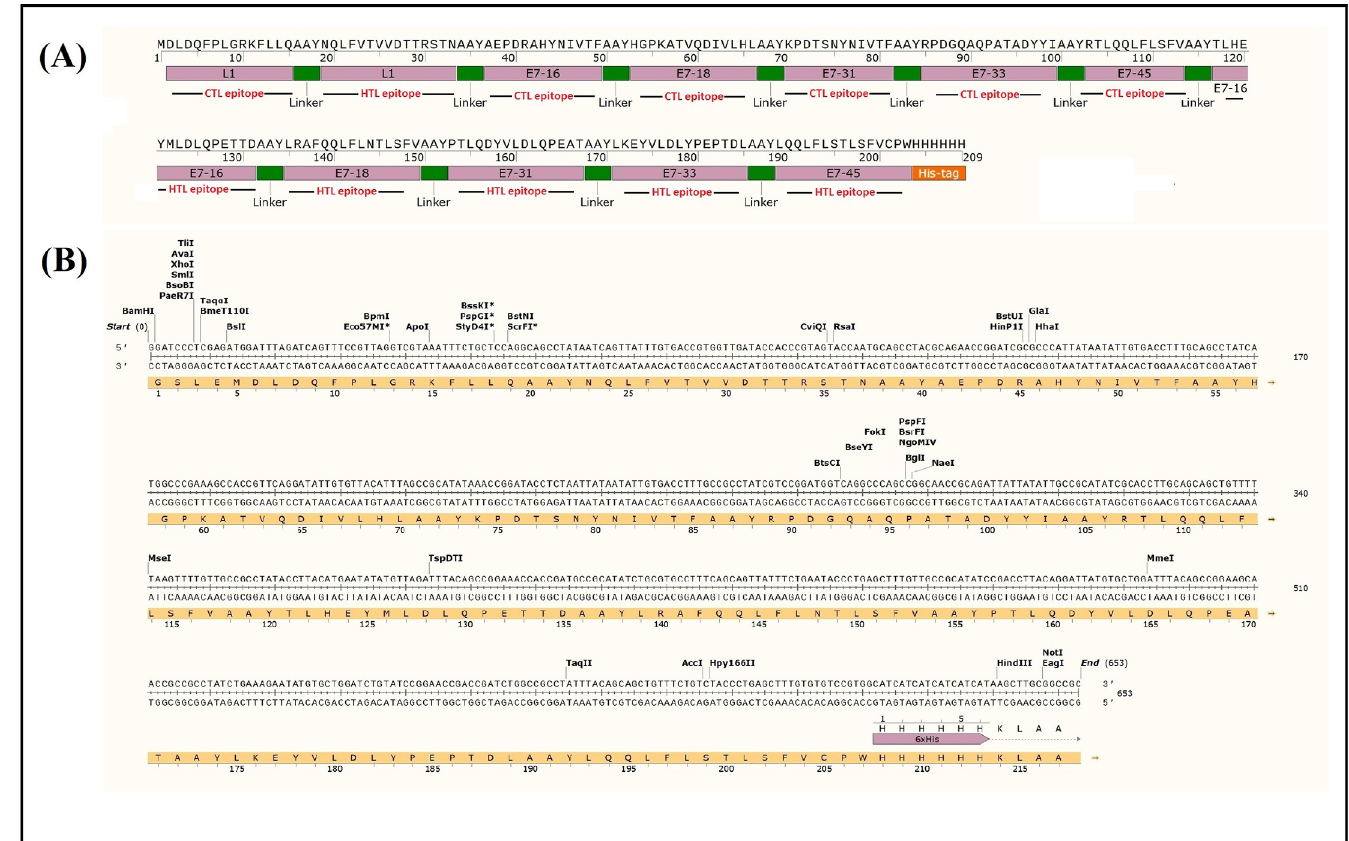
Fig 2. The L1-E7 multiepitope peptide and DNA constructs. A) The L1-E7 multiepitope peptide construct with 6xHis-tag: The helper T lymphocyte (HTL) and cytotoxic T lymphocyte (CTL) epitopes were shown as underline text; B) The multiepitope DNA construct with the restriction enzyme sites.